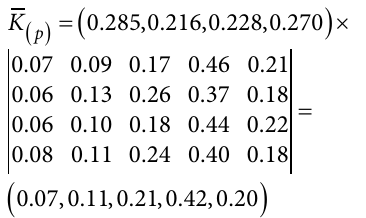
Table 7. MF for stages for the procurement process (for overall probability and severity indicators)